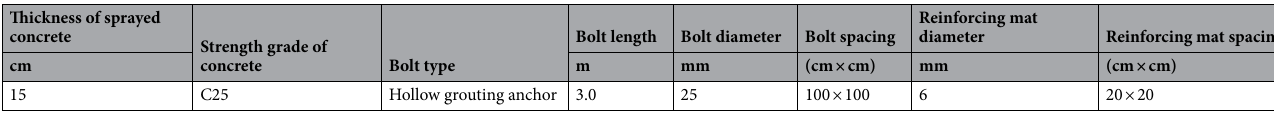
Table 2. Parameters of the primary